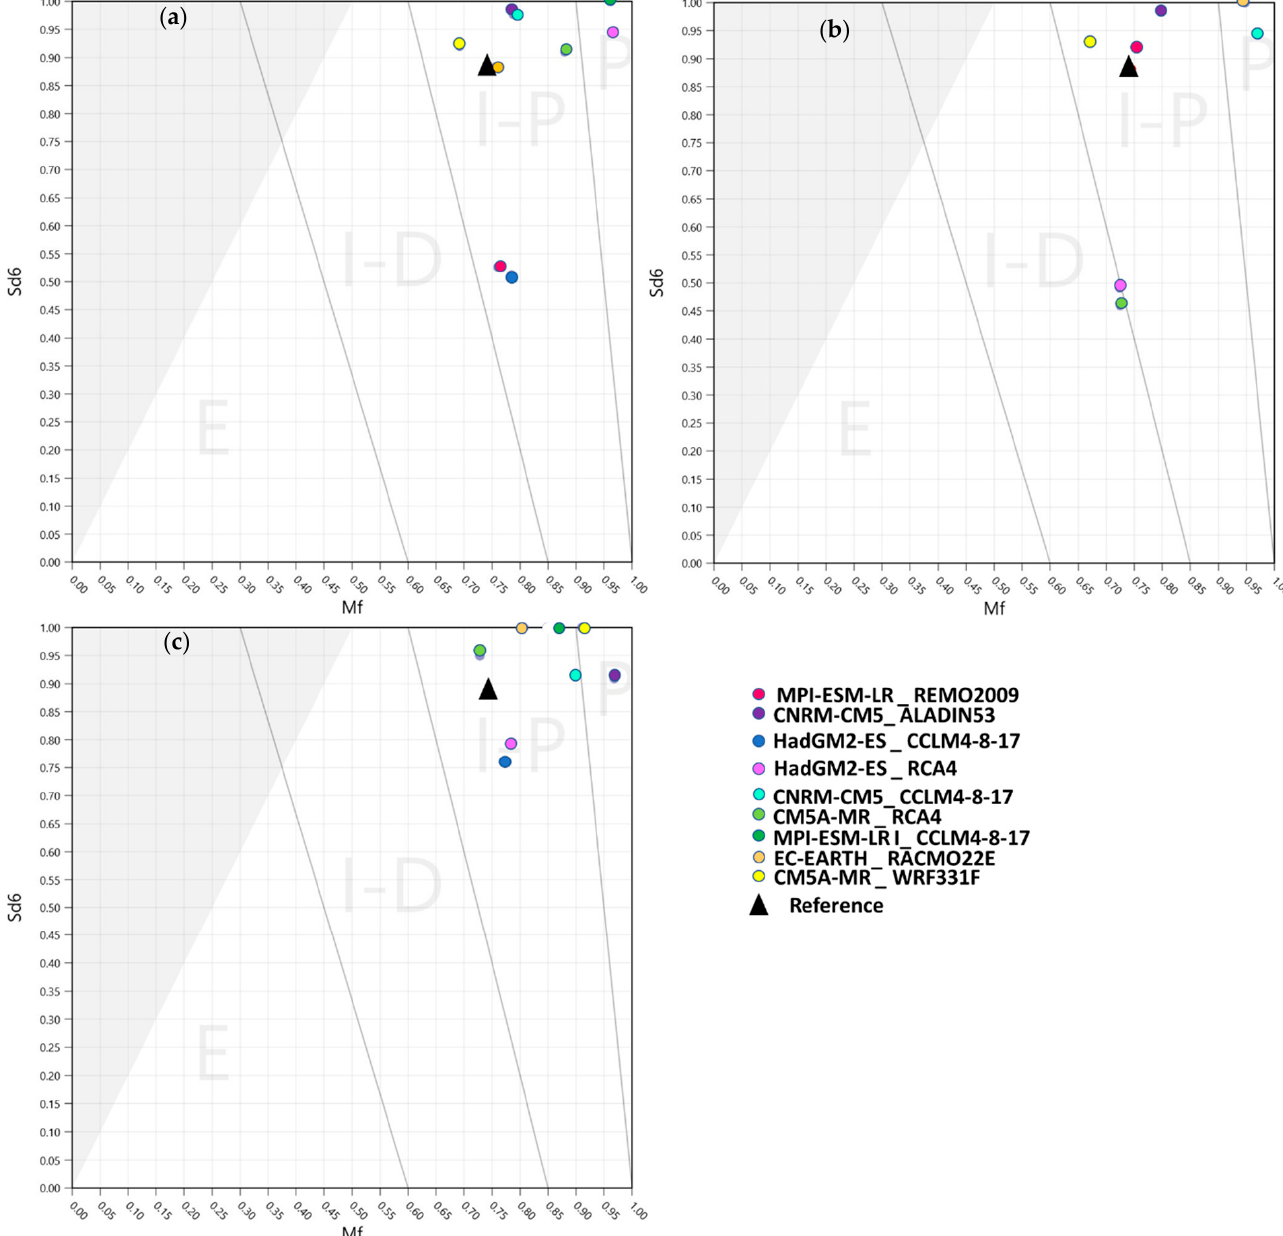
Figure 15. TRPs for the diverse sources: ( a ) RCP 4.5; ( b ) RCP 8.5; and ( c ) historical.